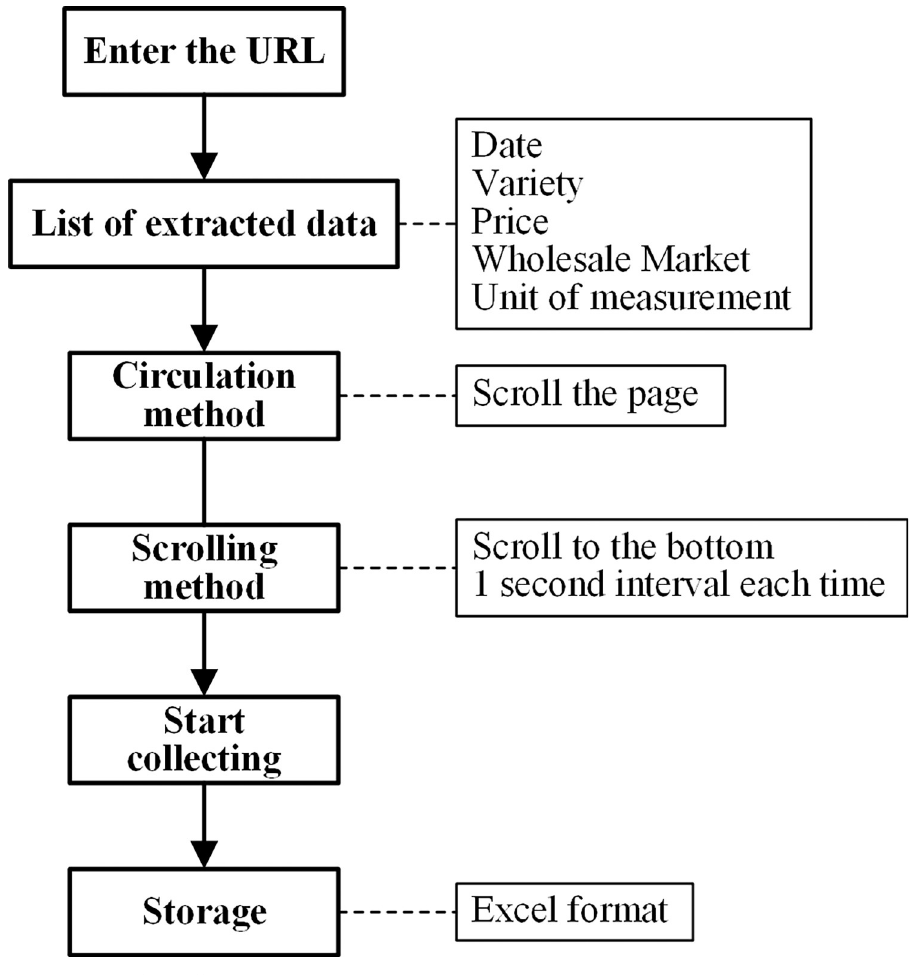
Fig 1. Octopus data collection